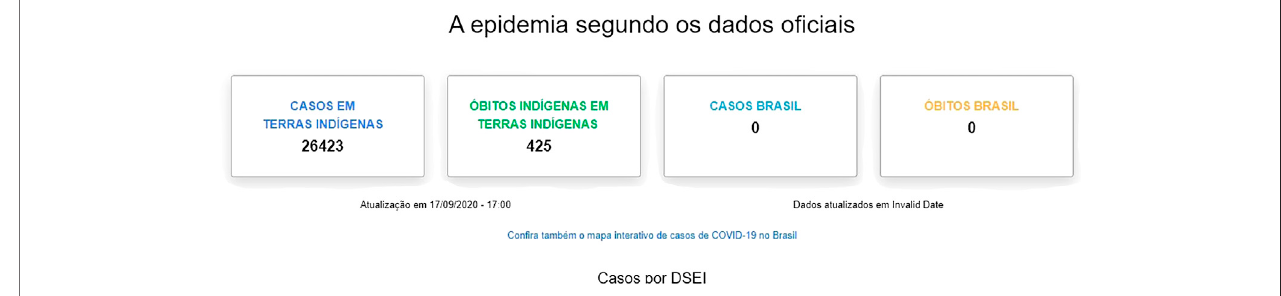
FIGURE 2 | https://covid19.socioambiental.org/.